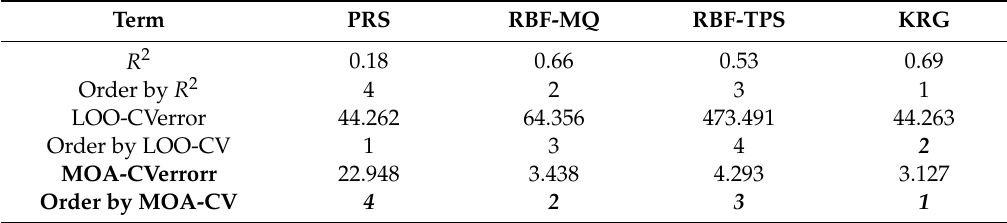
. Table 4. Ranking results of surrogate models by MOA-CV with different σ . Orders